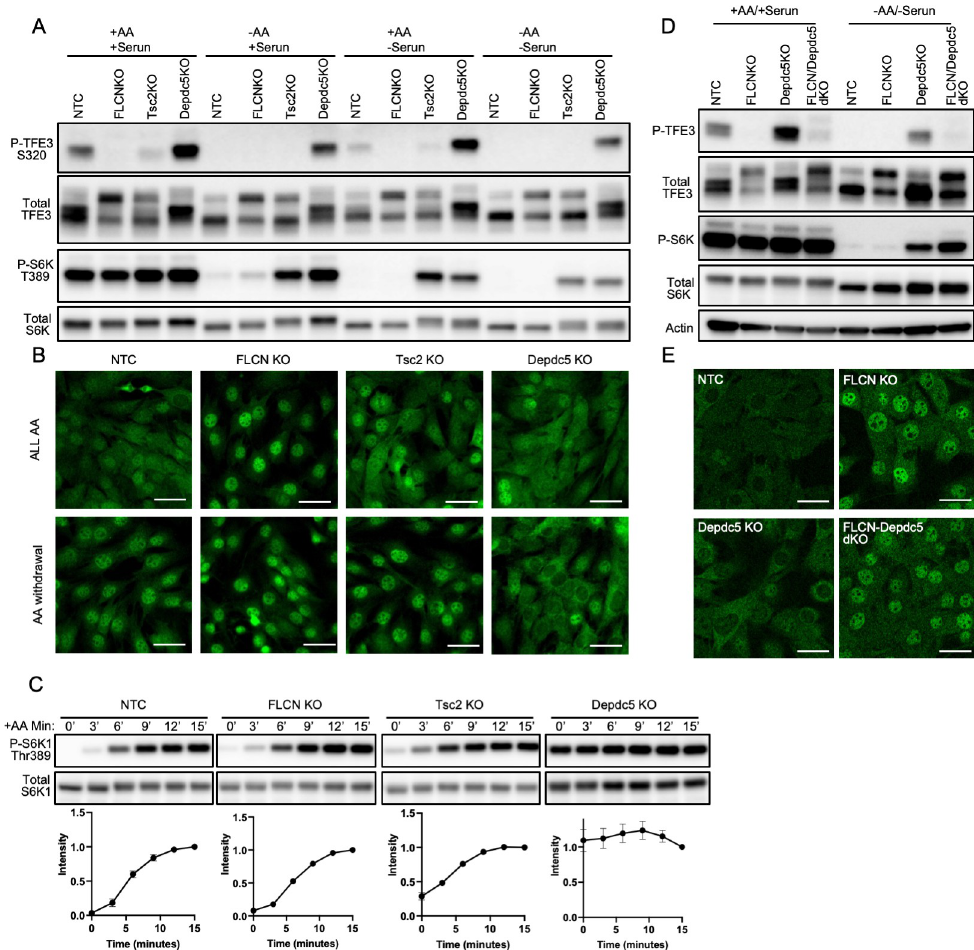
Fig 1. TFE3 phosphorylation is responsive to AAs, via the GATOR complex. (A, B) Control C2C12 cells (NTC) or cells lacking Flcn, Tsc2, or Depdc5, as indicated, were switched from complete medium to media lacking serum and/or AAs, as indicated, for 60 minutes, followed by immunoblotting for TFE3, phospho-TFE3, S6K, and phospho-S6K (A) or immunohistochemistry for subcellular localization of TFE3 (B). (C) The same cells as in A, after 60 minutes in medium lacking AAs, were returned to complete media for the indicated time points and immunoblotted for S6K, and phospho- S6K. Values were normalized to the 15-minute time point of each line. (D, E) C2C12 cells lacking Flcn, Depdc5, or both, as indicated, were evaluated as in A and B. The data underlying all the graphs shown in the figure is included in S1 Data. A AU : AbbreviationlistshavebeencompiledforthoseusedthroughoutFigs 1 (cid:0) 5 : Pleaseverifythatallentriesarecorrect : A, amino acid; FLCN, folliculin; KO,